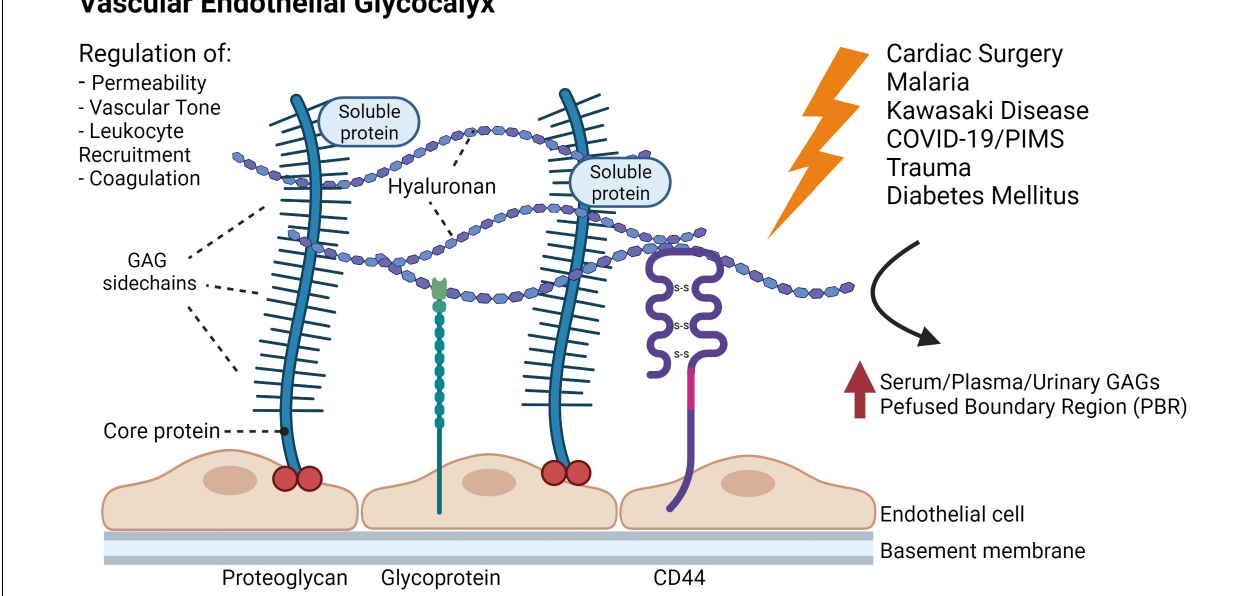
FIGURE 1 | Schematic representation of the glycocalyx covering the endothelial cells of a blood vessel. The main membrane bound components of the EG include proteoglycans (e.g., syndecans and glypicans) with long glycosaminoglycan side-chains (GAGs) and glycoproteins (e.g., selectins and integrins). Hyaluronan, plasma proteins and soluble proteoglycans are integrated into the glycocalyx forming the so called endothelial surface layer. The EG is an important regulator of vascular function and homeostasis, and shedding of the EG has been suggested in different conditions and disease states in the pediatric population including cardiac surgery, trauma, infectious diseases and diabetes mellitus. Note: dimensions in the figure are not drawn to scale. The figure was created with